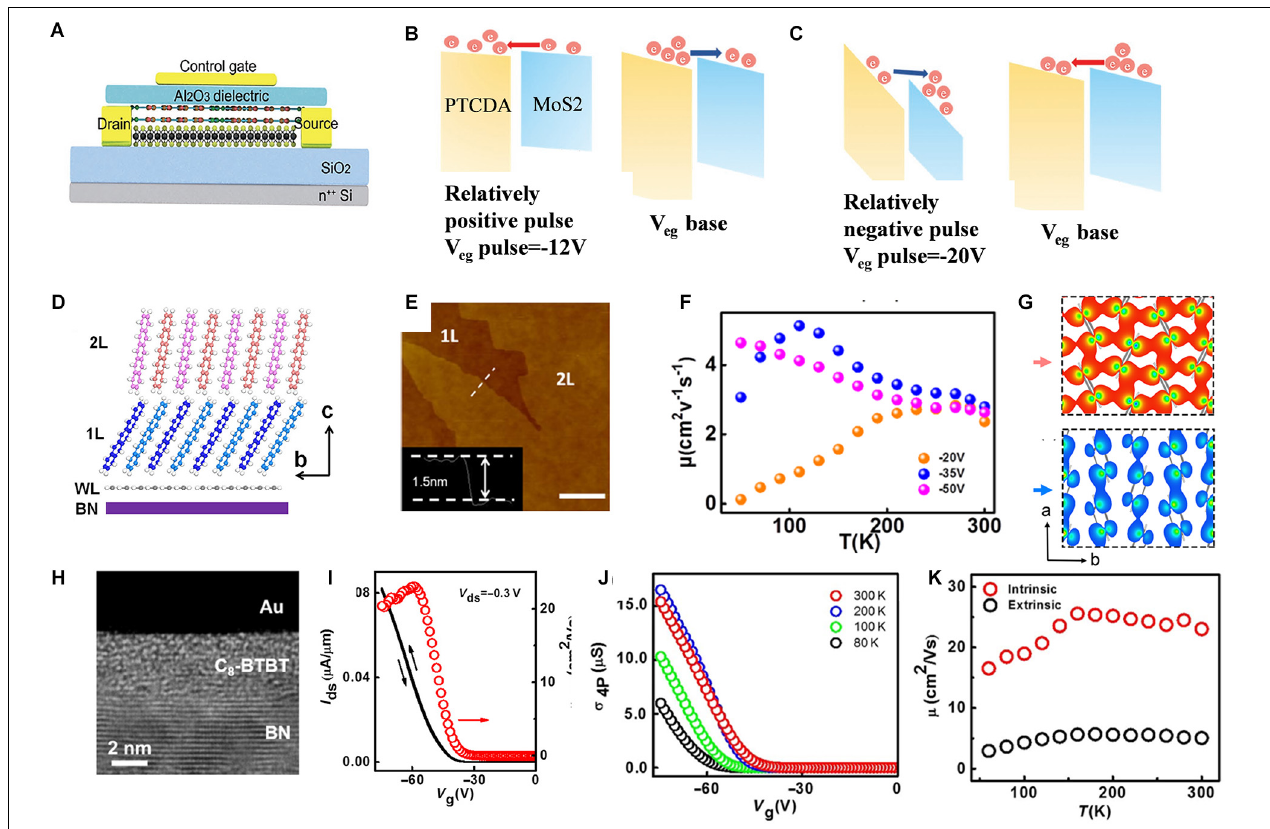
FIGURE 8 | Bio-electronic devices based on OSC/2D heterojunctions, and fundamental studies on highly ordered OSC films grown on 2D templates. (A) Structure of the synapse device based on a MoS 2 /PTCDA hybrid heterojunction under electrical modulation. Operating mechanism of (B) inhibitory and (C) excitatory synaptic behaviors. Reproduced from Wang et al. (2019) with permission from Copyright 2019 Wiley. (D) Schematic illustration of the molecular packing of 1L and 2L pentacene on h-BN. (E) AFM image of 2L pentacene crystals on h-BN. Insets are the height profiles as indicated. (F) Mobility as a function of temperature under different V G . (G) Top views of the molecular orbitals of the intermolecular bonding states in the slices cleaved in the a-b plane for 1L pentacene (blue) and 2L pentacene (red). Reproduced from Zhang et al. (2016) with permission from Copyright 2016 American Physical Society. (H) Cross-sectional TEM image of an Au/C 8 -BTBT/h-BN stack, showing atomically smooth interface. (I) Room temperature double-sweep I ds -V G characteristics (black line) and the extracted four-terminal field-effect mobility as a function of V G (red circle) of the monolayer C 8 -BTBT/h-BN FET. (J) Channel conductance as a function of V G under different temperatures of the monolayer C 8 -BTBT/h-BN FET. (K) Extrinsic and intrinsic mobility as a function of temperature of the monolayer C 8 -BTBT/h-BN FET. Reproduced from He D. et al. (2017) under the Creative Commons CC BY